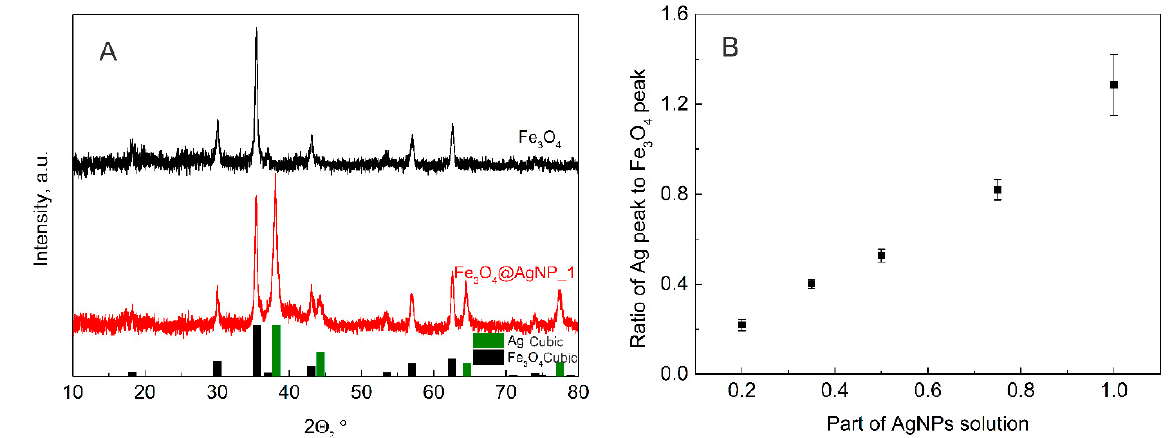
Figure 3. ( A ) XRD diffractograms of magnetite NPs (black) and magnetite NPs decorated with the highest amount of AgNPs (Fe 3 O 4 @AgNP_1; red); Crystallography Open Database files of magnetite (No. 9007644) and silver (No. 5000218) are presented in black and green columns, respectively. ( B ) Ratio of the main magnetite (35.4°) and silver (38.2°) peak intensities calculated for the different volume of AgNP solution used in decoration of magnetite.